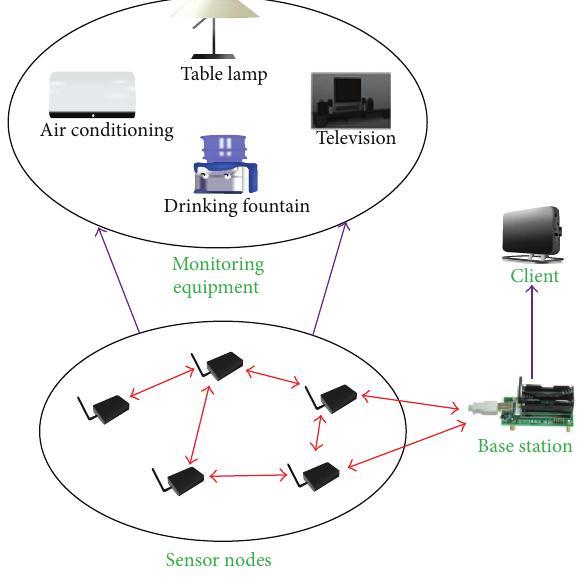
Figure 1: Architecture of the